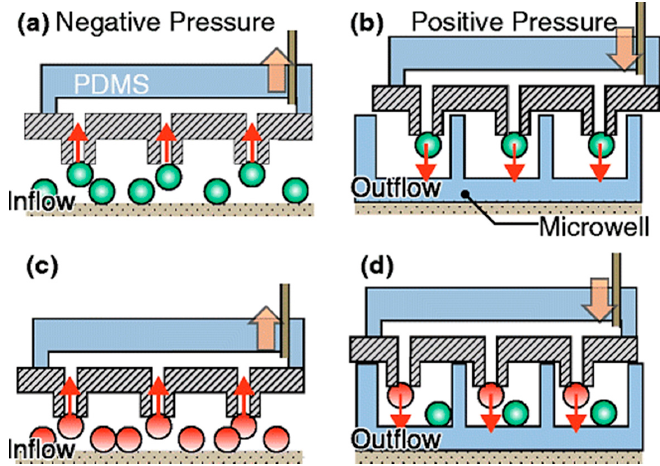
Figure 7 . Schematic representation of parallel manipulation of single-cells: The orange arrows represent the direction of movement of air on application of pressure and the red arrows represent the direction of the movement of cells due to applied pressure. ( a ) Pattern-based trapping of one type of single-cells; ( b ) Releasing the cells after transportation; ( c ) Suction of another type of single-cells; ( d ) Transport of another type of cells for co-culture. Reprinted with permission from [70]. Copyright (2015) Springer Nature.